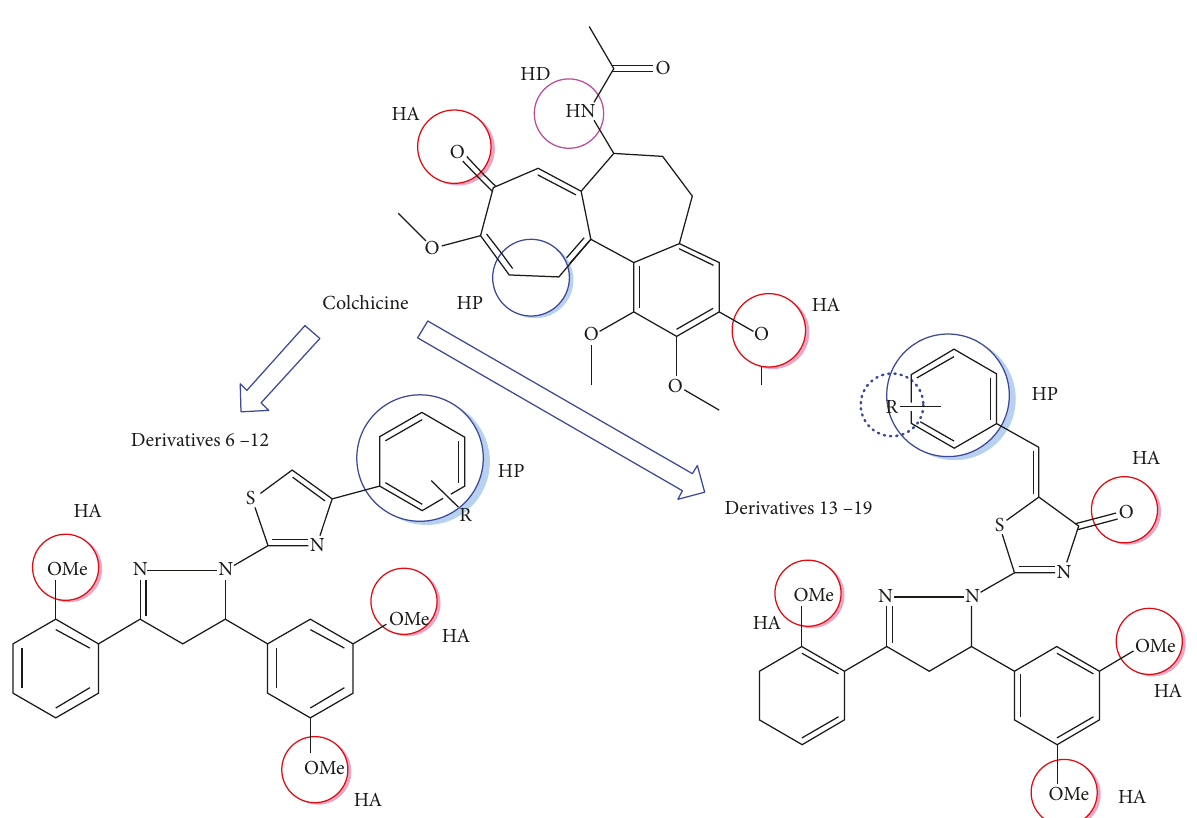
Figure 1: Schematic representation of the pharmacophoric characteristics of the derivatives where HA, HD, and HP denote hydrogen bond acceptor, donor, and hydrophobic centers,